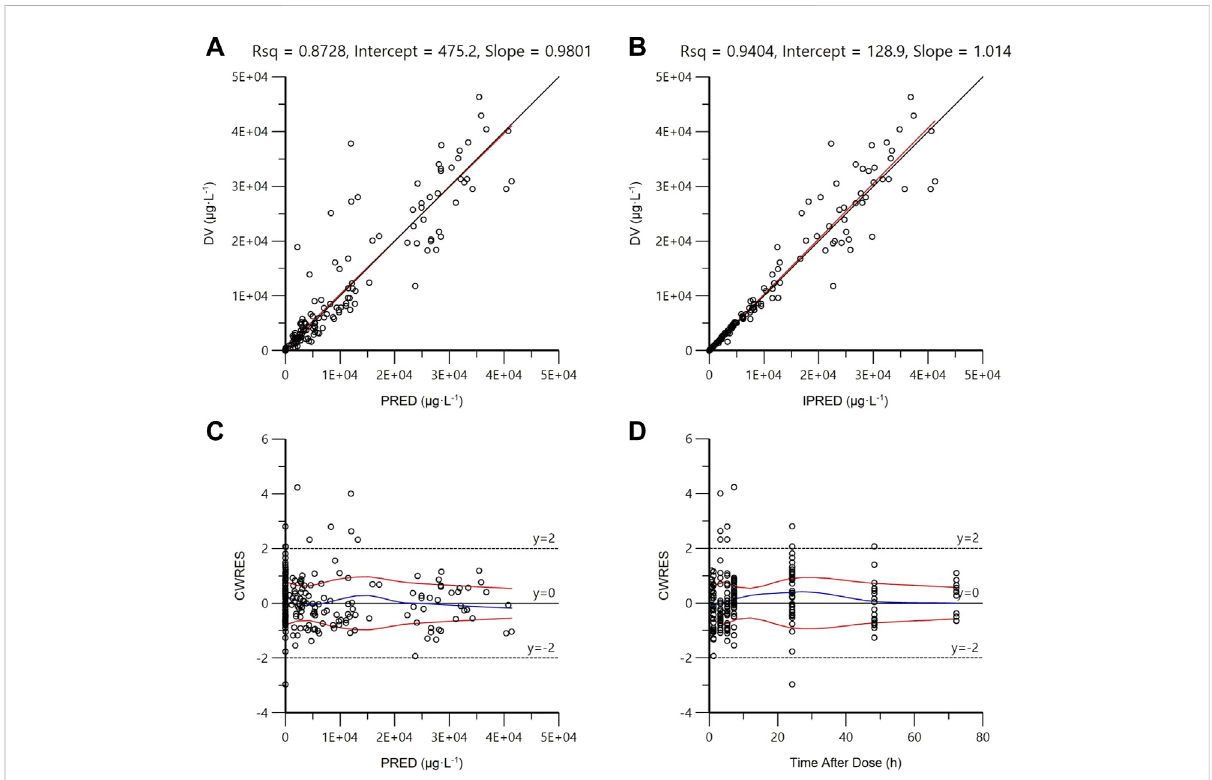
FIGURE 3 Goodness-of- fi tplots ofthe fi nalfullmodel. (A) Observedconcentrations (DV)vs.populationprediction (PRED); (B) DV vs.individualprediction (IPRED); (C) Conditional weighted residuals(CWRES)vs. PRED; (D) CWRES vs. time after dose. The uniform line and theregressionline are presented in (A) and (C) . The tendency curves of CWRES are shown in (C) and (D)